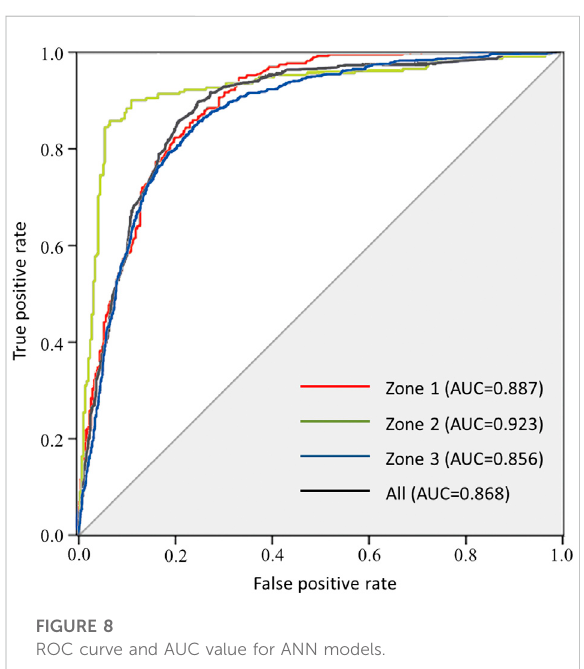
FIGURE 8 ROC curve and AUC value for ANN